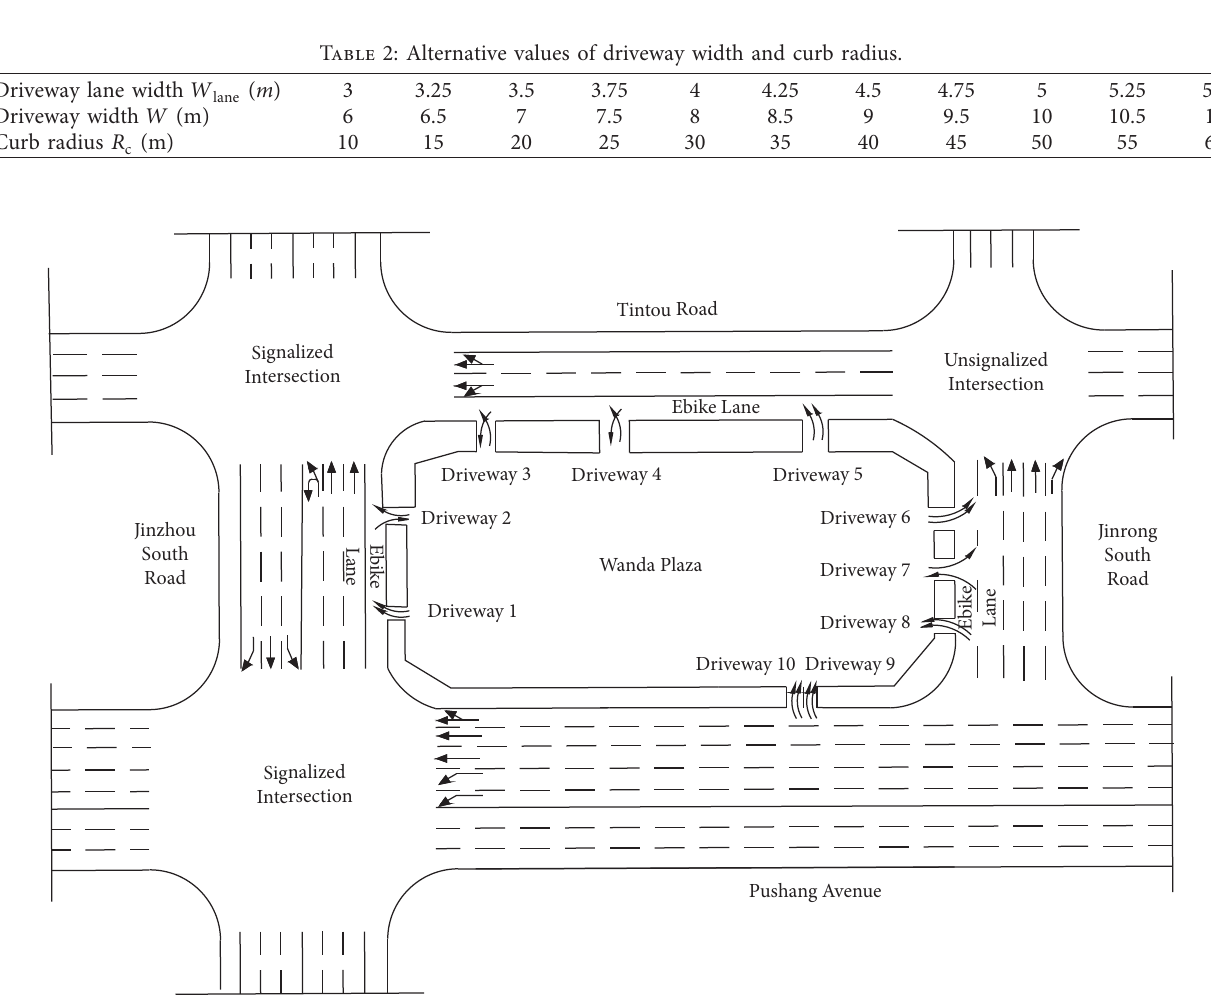
Figure 16: Driveway system of Wanda